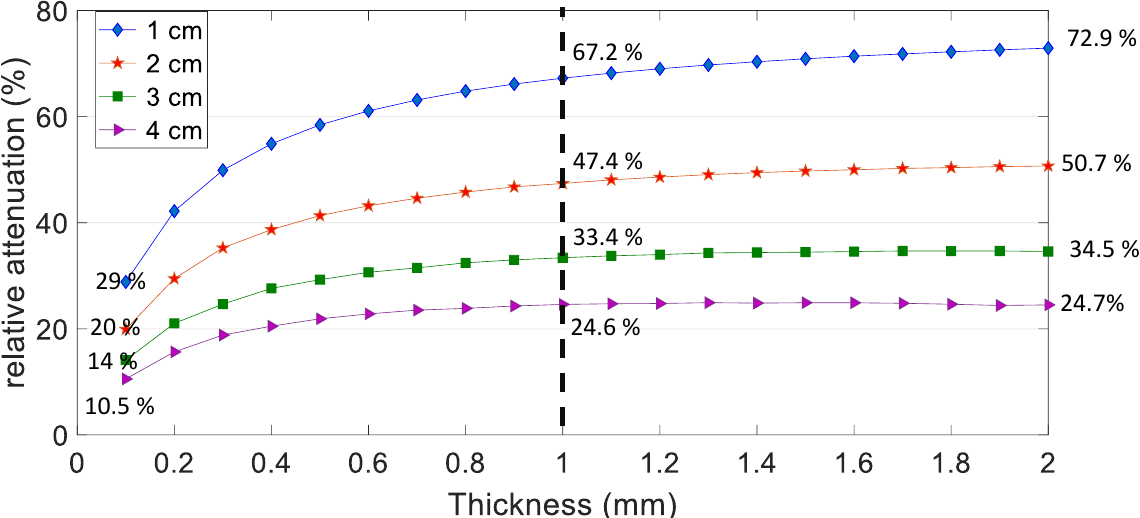
Figure 8. Configuration 1: relative attenuation percentage of MO with a constant reactive part value of 25 mm × 25 mm and a variable reactive-part thickness, as derived for four distinct distances between tool and external